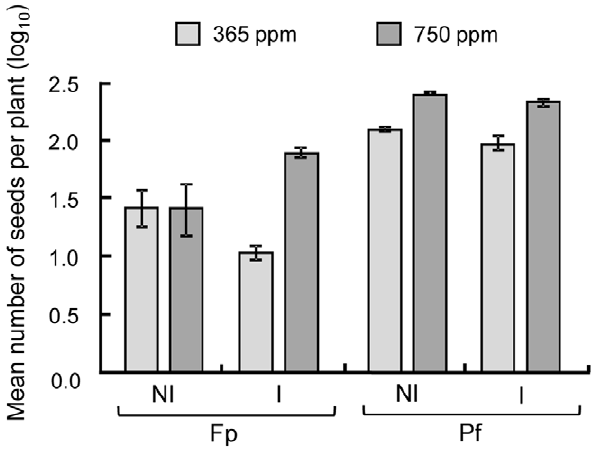
Figure 4. Average number of seeds per plant. Average number of seeds per plant depends on the CO 2 concentration (ambient, 365 ppm or enriched, 750 ppm), the condition of inoculation (I: inoculated or NI: not with Pseudomonas fluorescens C7R12) and the developmental stage of Medicago truncatula (Fp, Pf, see text). Data were log-transformed to achieve normality and equal variances respectively tested by Shapiro- Wilk and Bartlett tests. Number of seeds, measured during the second experiment replicate only, was analysed by linear model with condition of inoculation, CO 2 concentration and developmental stage as fixed factors and with their interactions. Standard errors are represented by vertical bars. doi:10.1371/journal.pone.0045740.g004 truncatula . If some N 2 -fixing P. fluorescens strains have been identified [40], there is no evidence that P. fluorescens C7R12 has this capacity. Another hypothesis is linked to the ability of P.